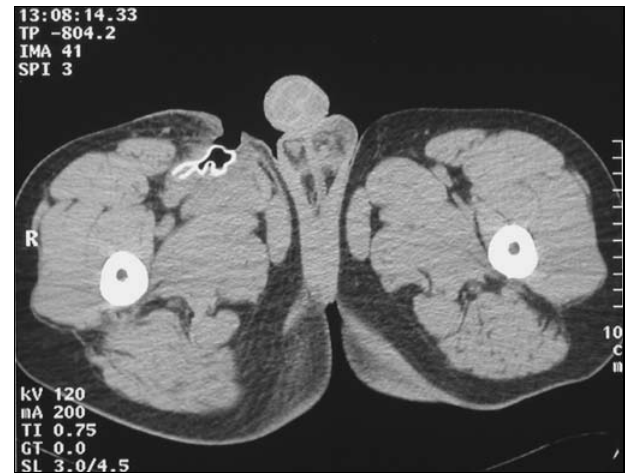
Fig. 2c. CT scan image through upper thighs shows Teflon felt in base of ulcer. Ulcer crater contains air; this accounts for the fine linear lucencies visible within the soft tissues of the right medial thigh on the pelvic